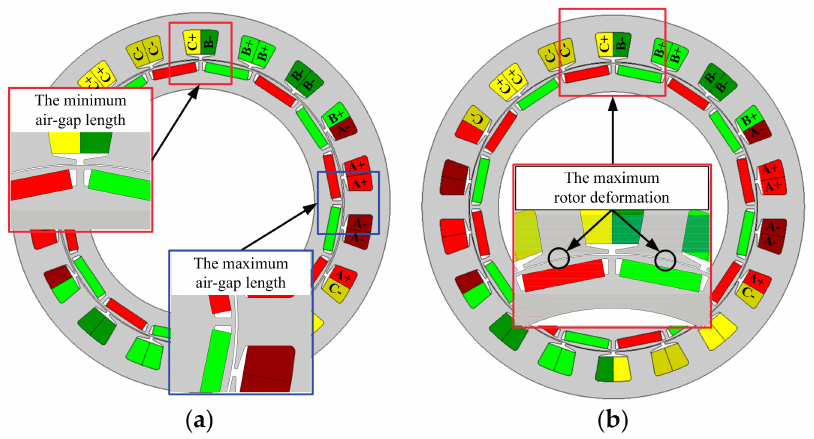
Figure 3. Electromagnetic FEMs of the IPMSM with air-gap deformation. ( a ) Stator oval deformation; ( b ) Rotor centrifugal distortion.